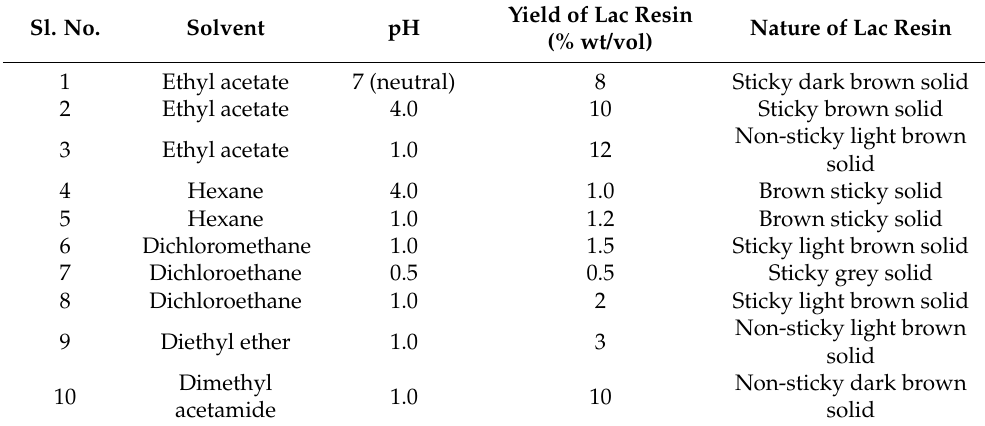
Yield of Lac Resin Nature of Lac Resin (% wt/vol) Non-sticky light brown